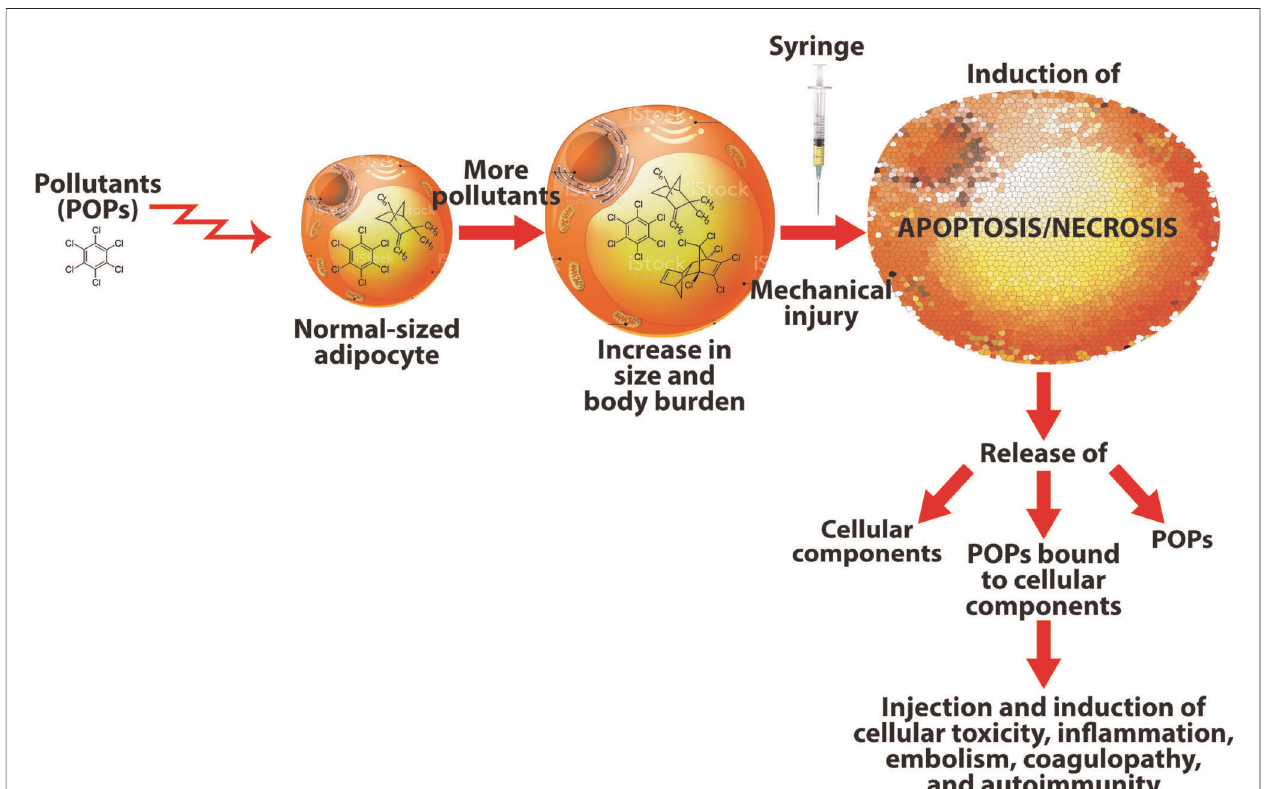
FIGURE 1 | How pollutants stored in adipocytes may lead to autoimmunity. Adipocytes fi lled with stored persistent organic pollutants (POPs) may burst upon extraction, releasing the POPs, cellular components, and POPs bound to cellular components into the syringe, which will inject all these materials into the patient, possibly inducing immune-mediated